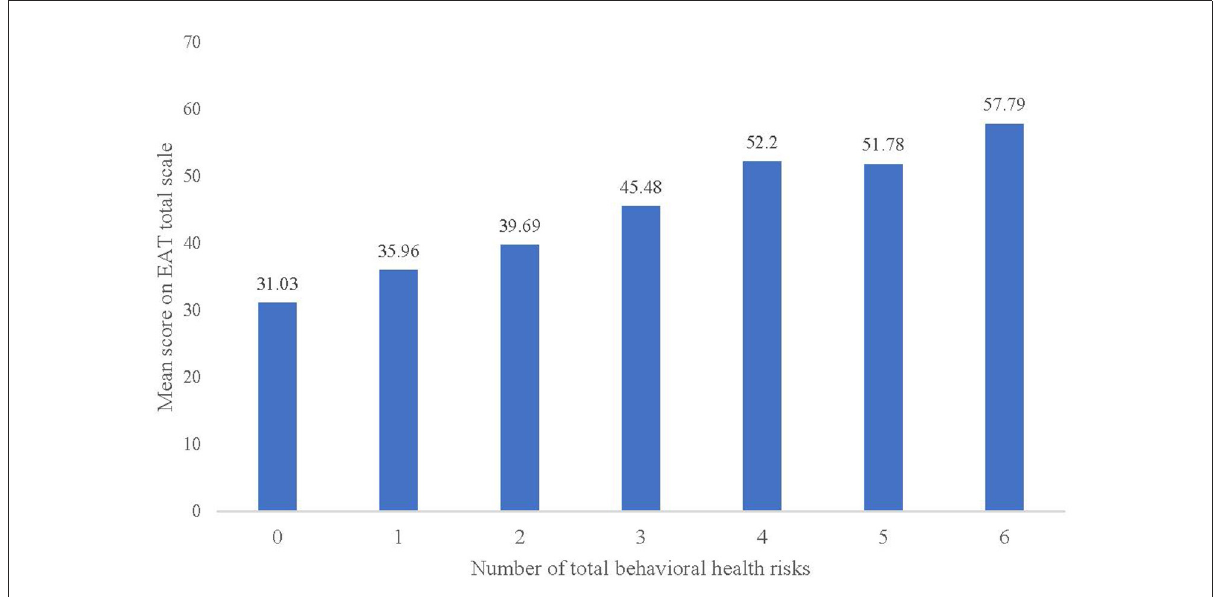
FIGURE2 Mix of the number of total behavioral health risks per person among